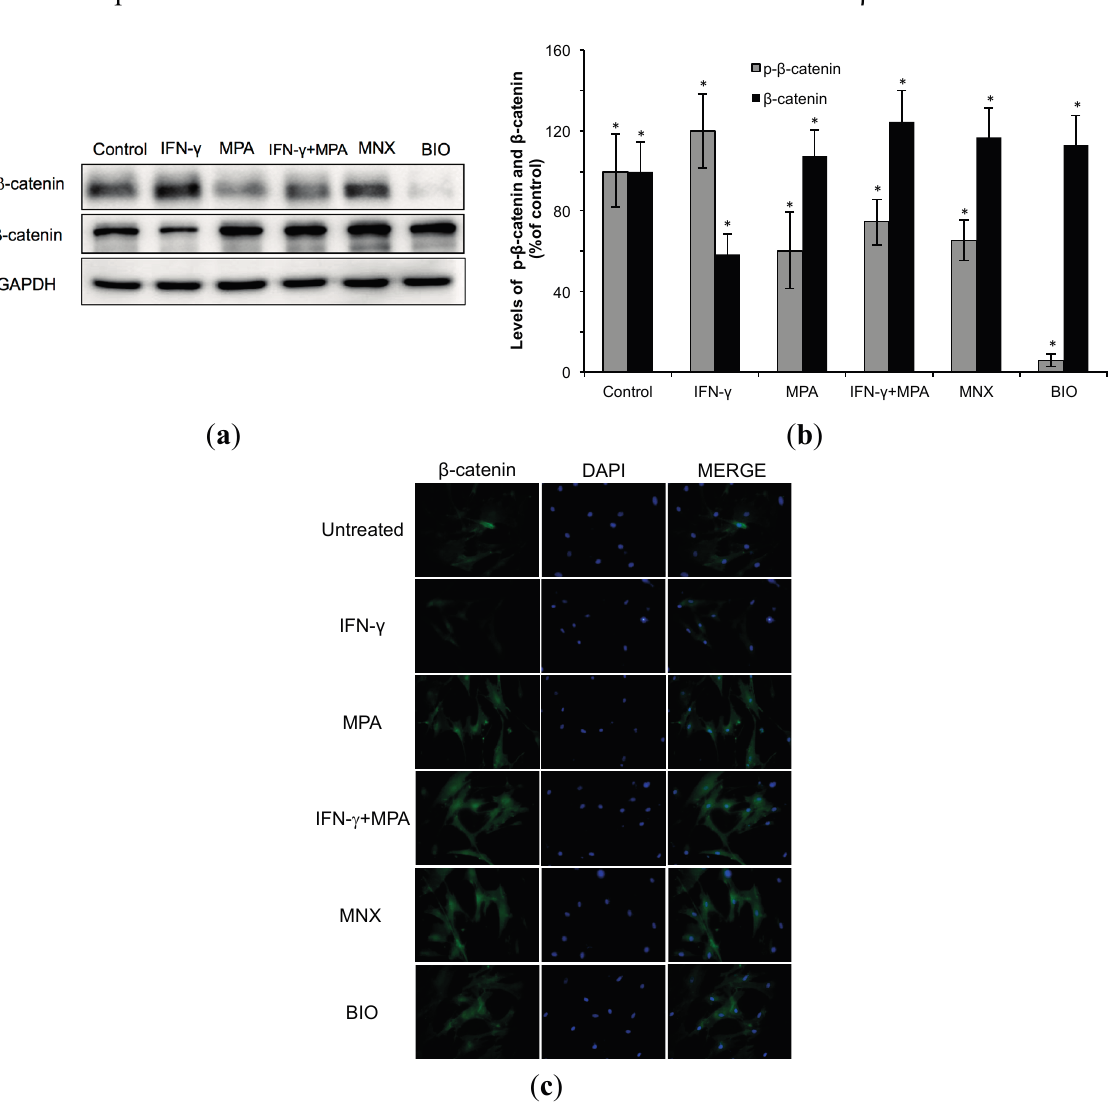
Figure 2. Stabilization and nuclear accumulation of β -catenin in hDPCs treated with MPA. hDPCs were treated with 100 ng/mL of IFN- γ , 100 nM of MPA, or with both IFN- γ and MPA for 48 h. ( a ) The protein level of β -catenin was examined by Western blot using anti-phospho- β -catenin and anti- β -catenin antibodies; ( b ) The relative level of β -catenin protein was shown as mean ± SD from three independent experiments. Statistically significant differences were determined by ANOVA (* p < 0.05); and ( c ) Intracellular localization of β -catenin was determined by immunocytochemistry staining using specific anti- β -catenin antibodies (green). Corresponding DAPI nuclear staining (blue) and the merged images are also shown. minoxidil (MNX) and 6-bromoindirubin-30-oxime (BIO) served as positive controls for stabilization and nuclear translocation of β